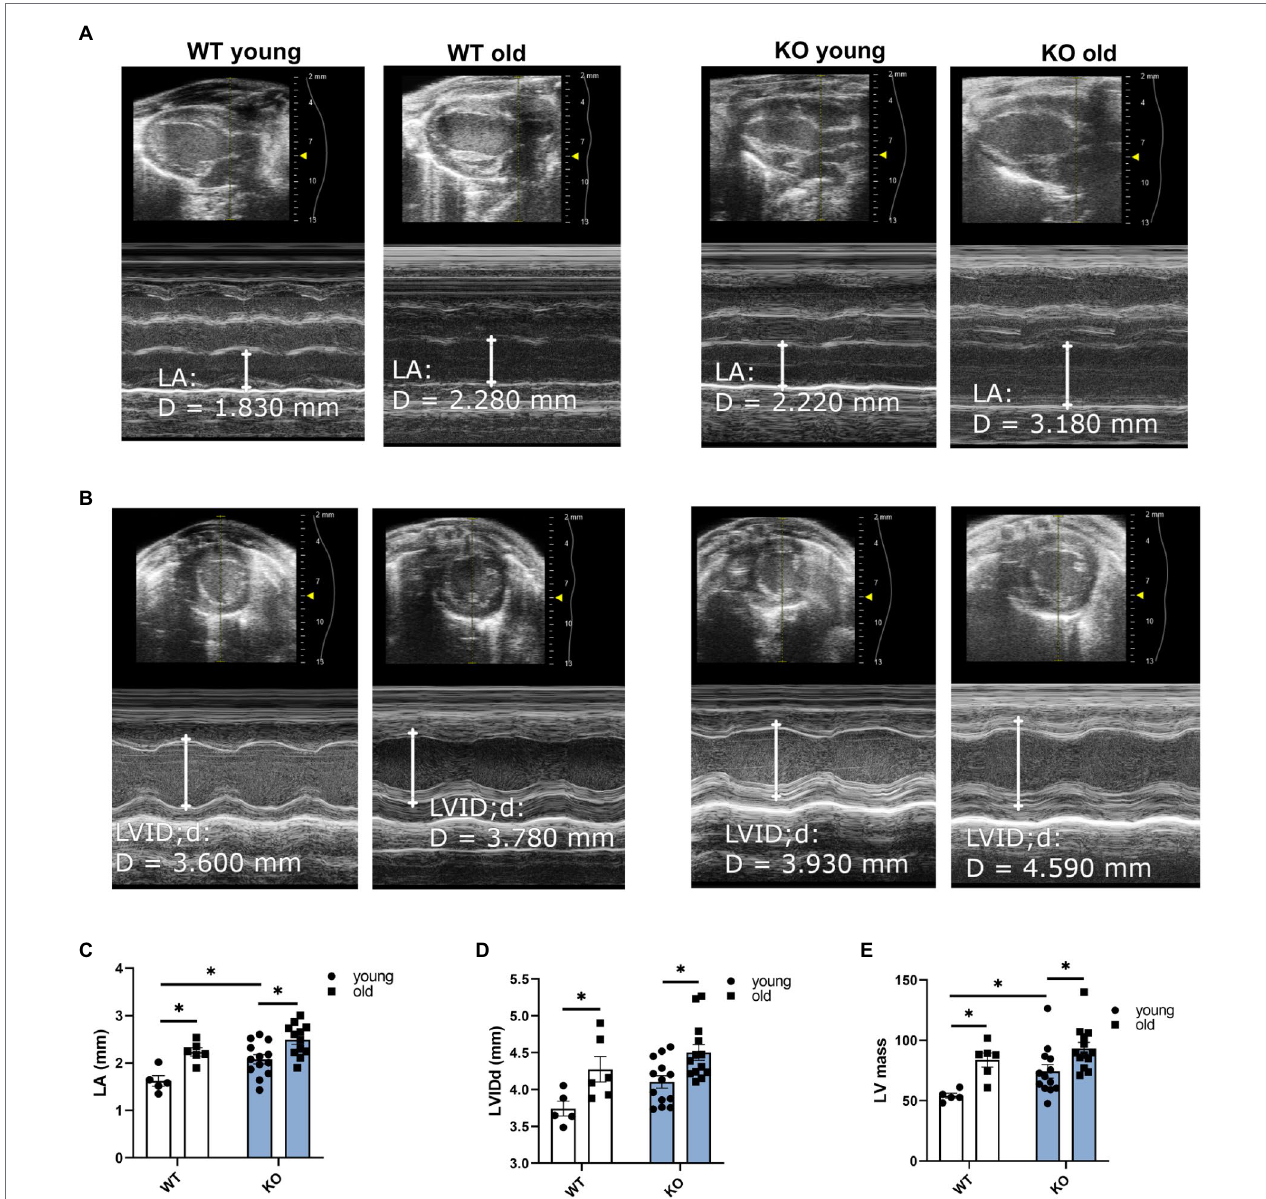
FIGURE 1 | Deletion of β -arrestin-2 causes enlargement of left atria and left ventricle in aged mice. Representative B-mode and M-mode long-axis images of (A) left atrium (LA) diameter and short-axis images of (B) left ventricular internal diameter during diastole (LVIDd) in young and aged WT and KO mice. Quantification of (C) LA and (D) LVIDd shows enlargement in both aged WT and KO mice. (E) Both aged WT and KO show increased left ventricular (LV) mass. Young: 3–6 months and old: 12–16 months. N = 5–13. Data presented as mean ± SEM. Outliers were identified with the ROUT method and excluded from analyses. Data analyzed with a two-way ANOVA post-hoc Fisher’s LSD test. * p <